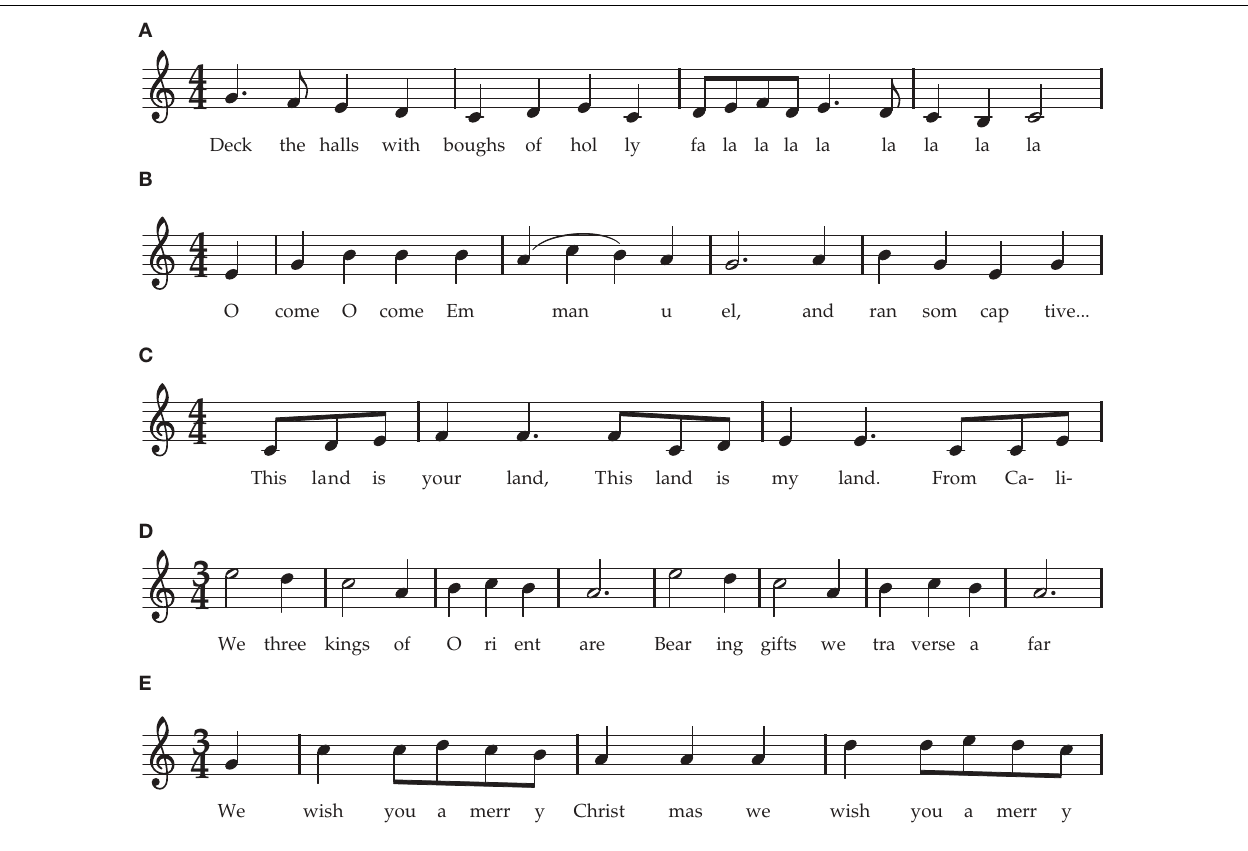
FIGURE 2 | Familiar Musical Examples of Meter with or without Anacrusis. (A) March Time (4:4), no pickup: “Deck the Halls.” (B) March Time (4:4) with one pickup note: “Oh Come Oh Come Emmanuel.” (C) March